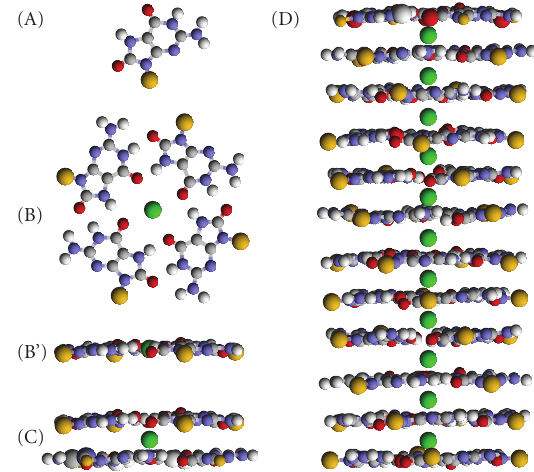
Figure 1: Representation of the aggregates formed by d(pG) in water (yellow and green beads represent the sugar-phosphate residue and the monovalent cation, resp.). (A) guanosine molecule; (B) and (B (cid:2) ) arrangement of four guanosine residues in a G-quartet (top and lateral views); K + , Na + , and NH 3+ have the right size to occupy the tetramer inner cavity; (C) lateral view of the G-octamer, formed by two stacked quartets; the cation is located between the two quartets; (D) lateral view of the G-quadruplex, formed by stacking of discrete cation-bound